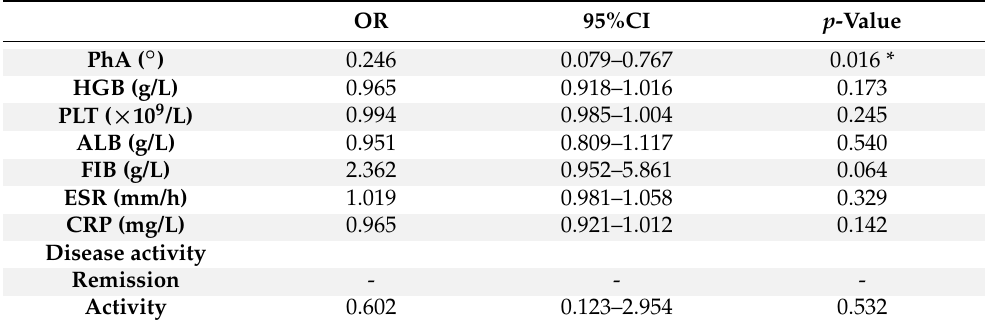
Table 5. Logistic regression analysis of predictors’ degree of malnutrition based on GLIM criteria in men.